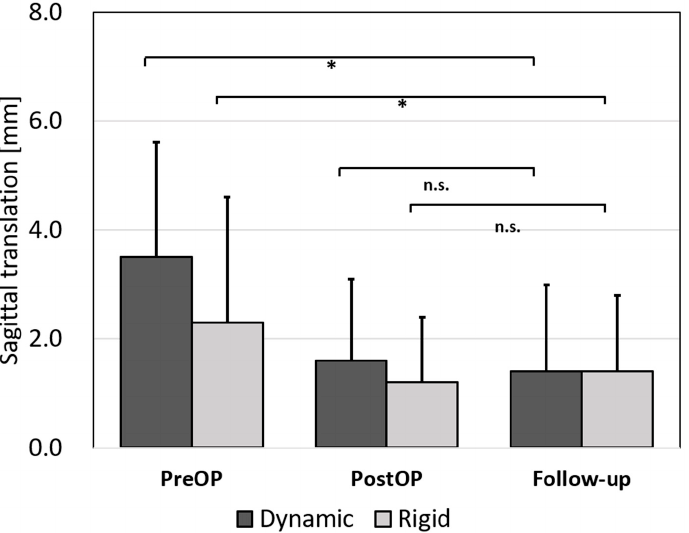
Figure 4. Changes in the sagittal translation. Sagittal translation pre-, postoperative and at the time of the last radiological follow-up. Bars indicate mean values and whiskers the SD. * indicates p < 0.05.